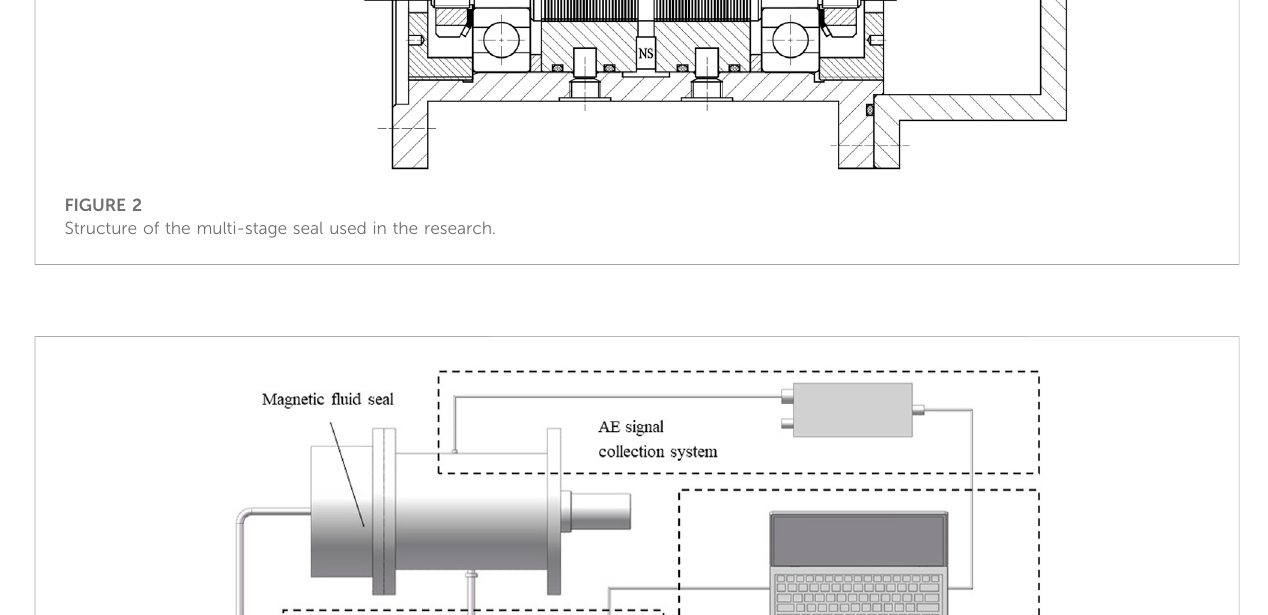
Phase 2: When Δ P wasraisedfurther,thebubblesmergedintoa thin jet-like passage through which steady leakage took place. Phase 3: When Δ P was raised still further, particles of the magnetic fl uid began to be hung out from the gap, until, at